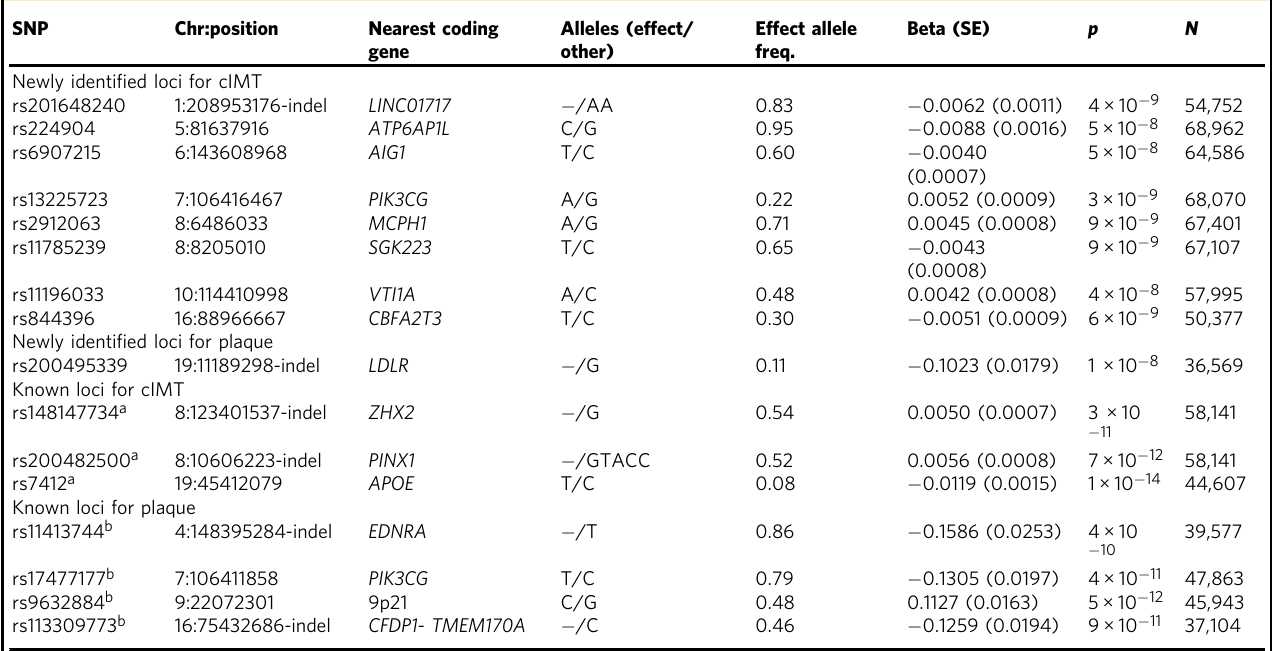
Table 1 Loci signi fi cantly associated with cIMT and plaque